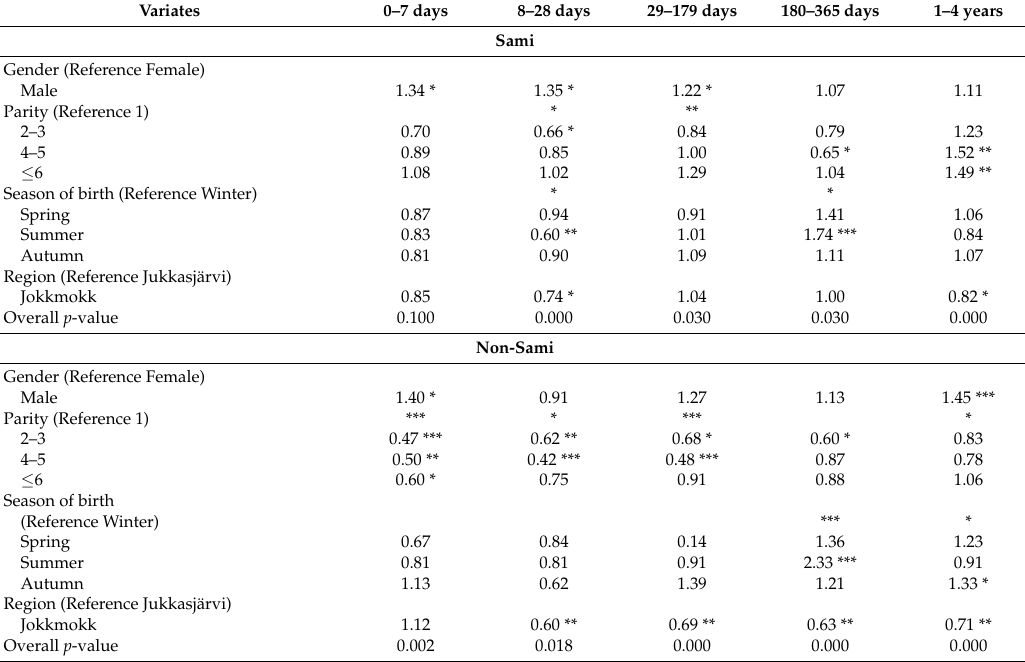
Table 3. Cox regression of infant and child mortality in S á pmi, 1800–1899, presented as relative risks, (exp (B)) 1